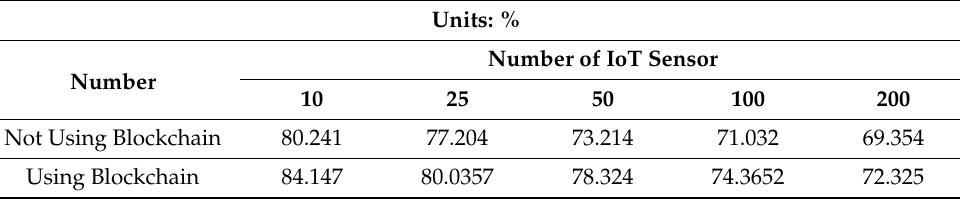
Table 7. Comparison of integrity accuracy of IoT